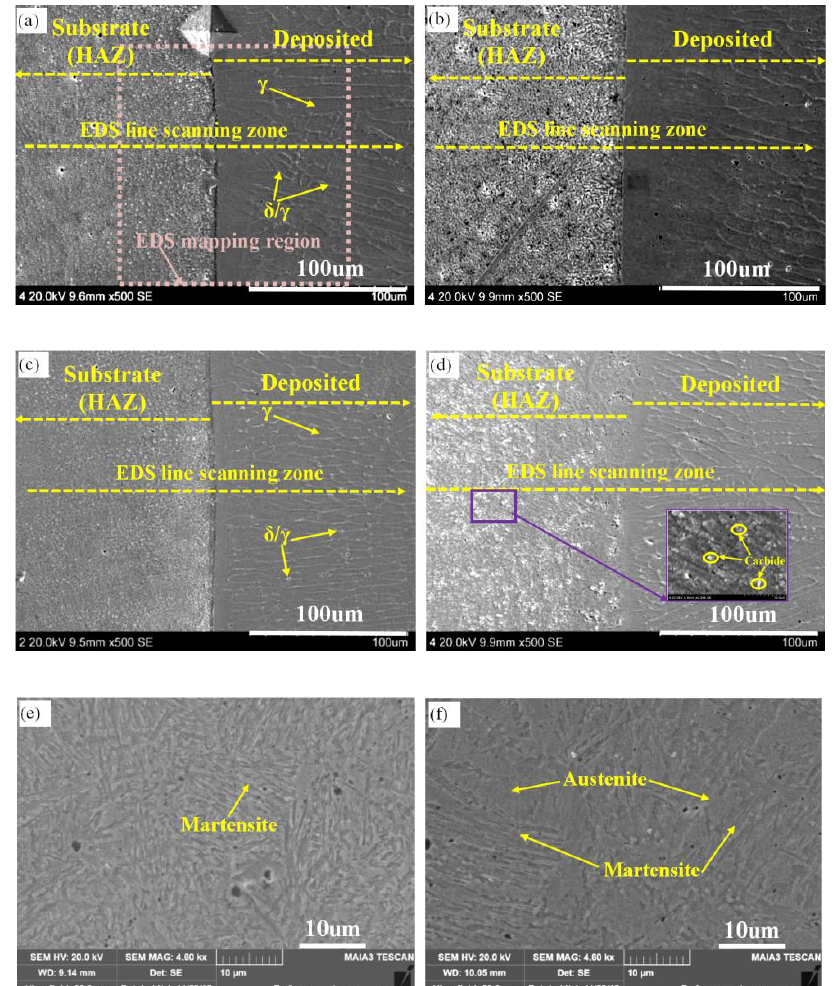
Figure 6. Microstructure of the cross-section of the bonding interface: ( a ) 316 L on 1045 steel; ( b ) 316 L on 1045 steel with substrate preheating; ( c ) 316 L on P20 steel; ( d ) 316 L on P20 steel with substrate preheating; ( e ) magnification of heat affected zone (HAZ) microstructure of P20; ( f ) HAZ microstructure of P20 under preheating.